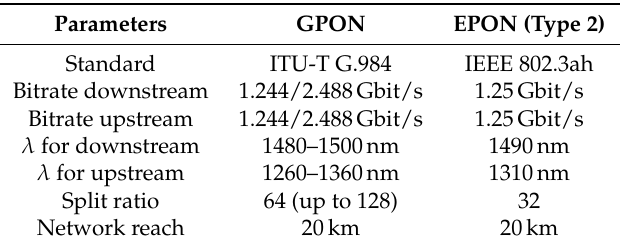
Table 1. Basic comparison of GPON with